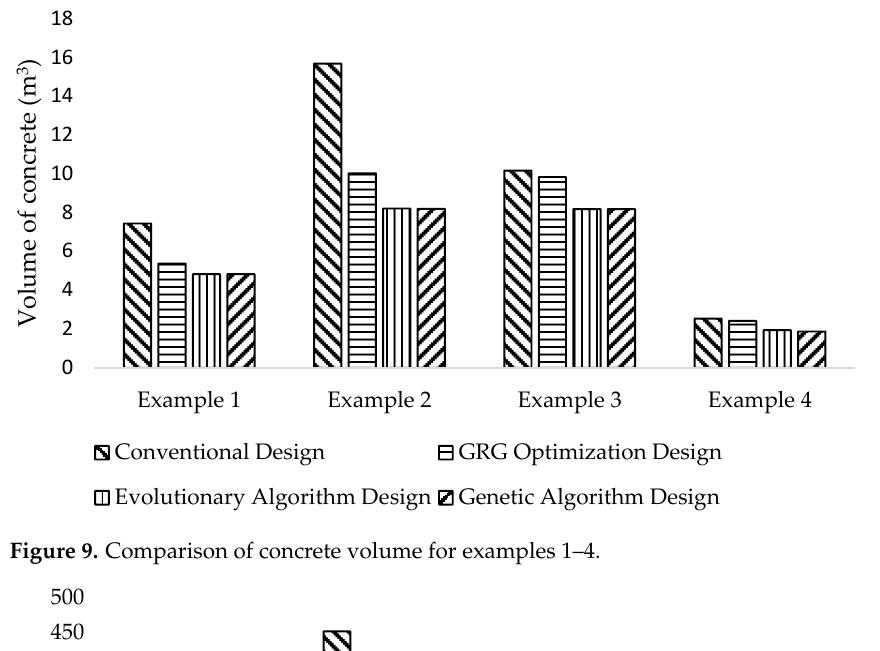
Figure 8. Comparison of area of the footing for examples 1–4.